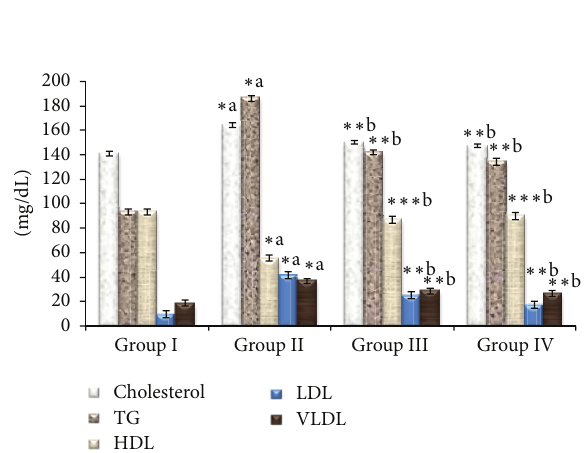
Figure 1: Effect of ethanolic extract of Triticum aestivum on the total cholesterol (TC), triglyceride (TG), HDL, LDL, and VLDL levels in STZ-induced rats. Values are the mean ± SD for six animals in each group. Values are statistically significant at ∗ P < 0.05, ∗∗ P < 0.001, and ∗∗∗ P < 0.01; statistical significance was compared within the groups as follows. a Diabetic rats were compared with normal rats. b Glibenclamide and Triticum aestivum treated diabetic rats were compared with diabetic